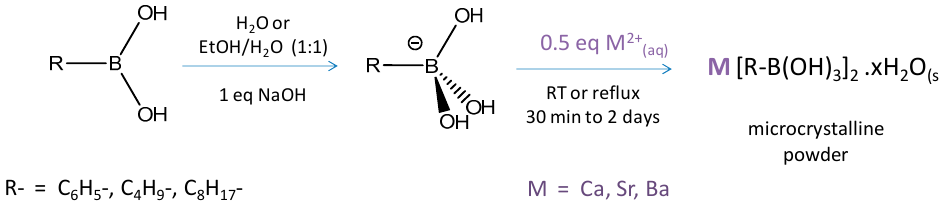
Figure 3. Reaction scheme for the formation of metal boronate crystalline structures by precipitation.